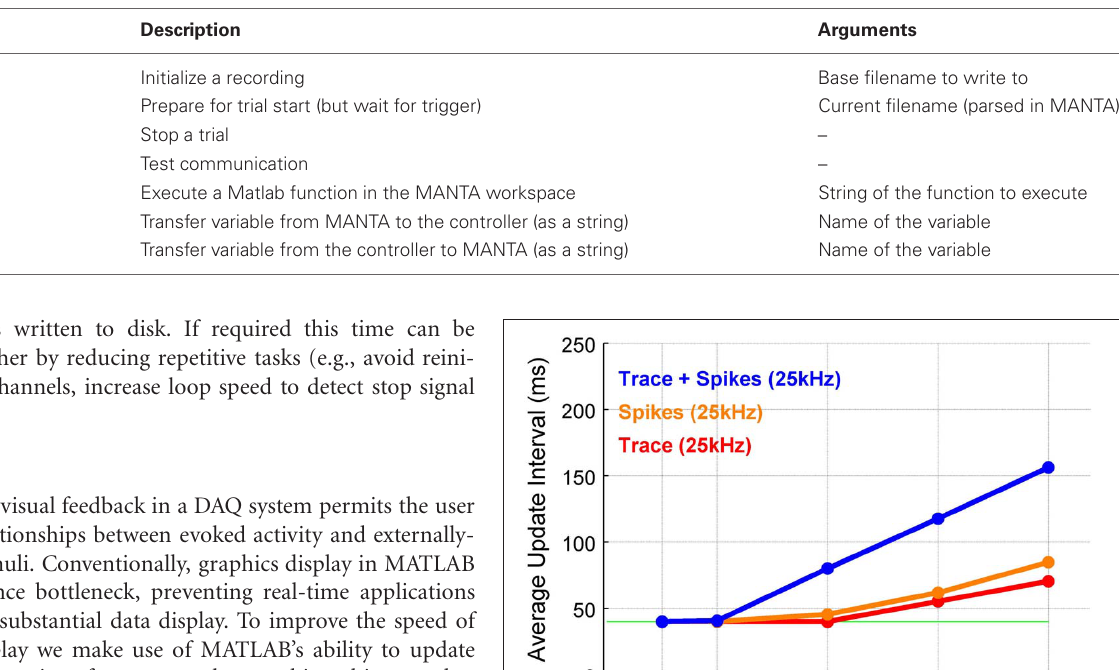
Table 2 | TCP/IP commands.